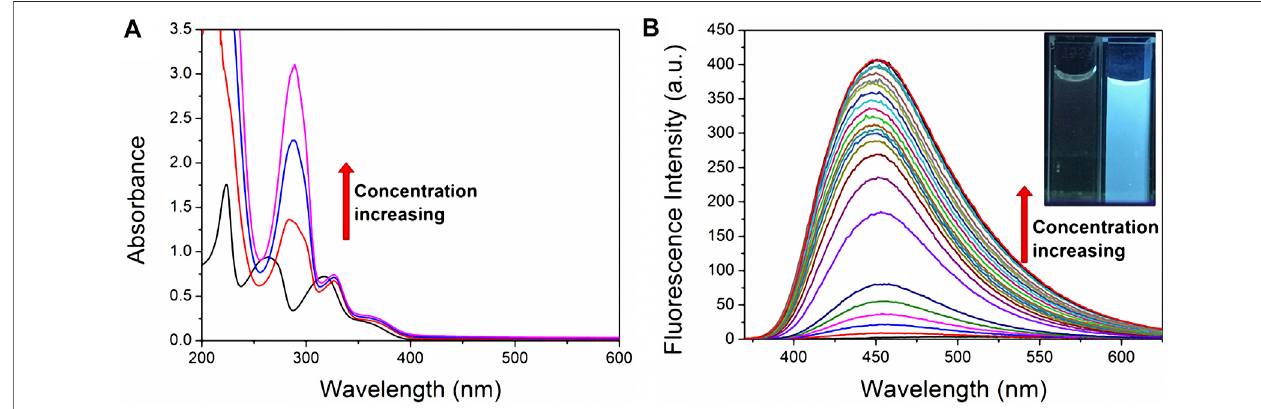
FIGURE 1 | UV-vis and fl uorescence titration on TNS with CP6 in PBS (pH 6.8). (A) Absorption spectra (20 µM TNS , 0 – 6.5 equiv. CP6 ) (B) fl uorescence spectra (20 µM TNS , 0 – 2.6 equiv. CP6 , λ ex = 318 nm). The inset illustrates enhanced fl uorescence in water when excited at 365 nm with a UV lamp set to 298